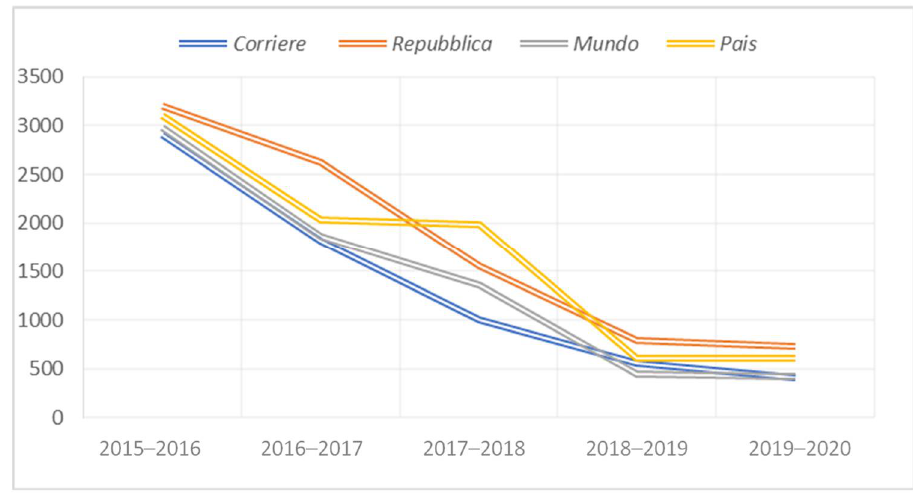
Figure 1. Chronological distribution of content containing Islam-related keywords. Source: elabo- rated by the authors.